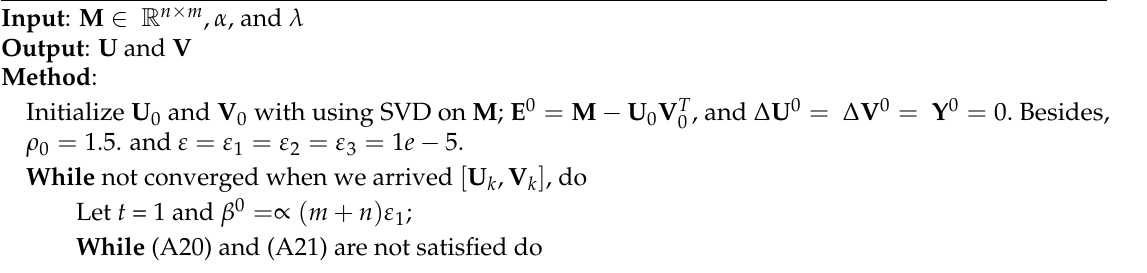
Algorithm A1 Graph Regularized Robust Matrix Factorization (GRMF) by Majorization